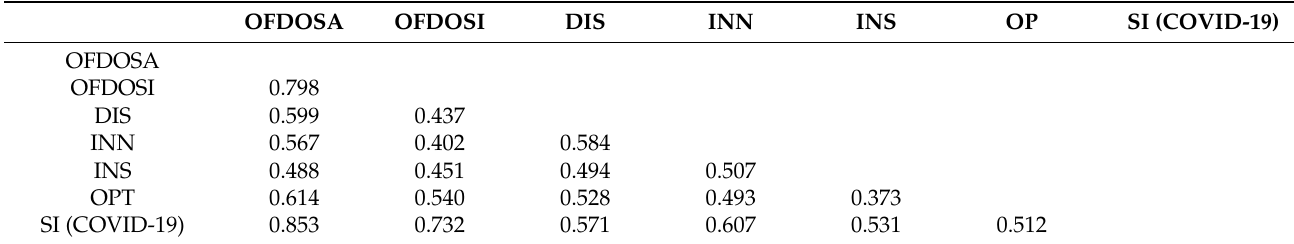
Table 3. Discernment validity.